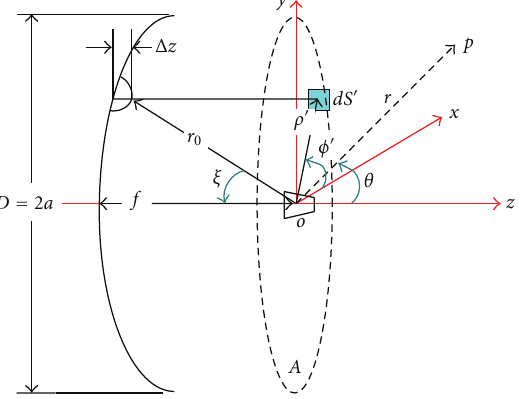
Figure 3: Schematic diagram of the reflector antenna with error.